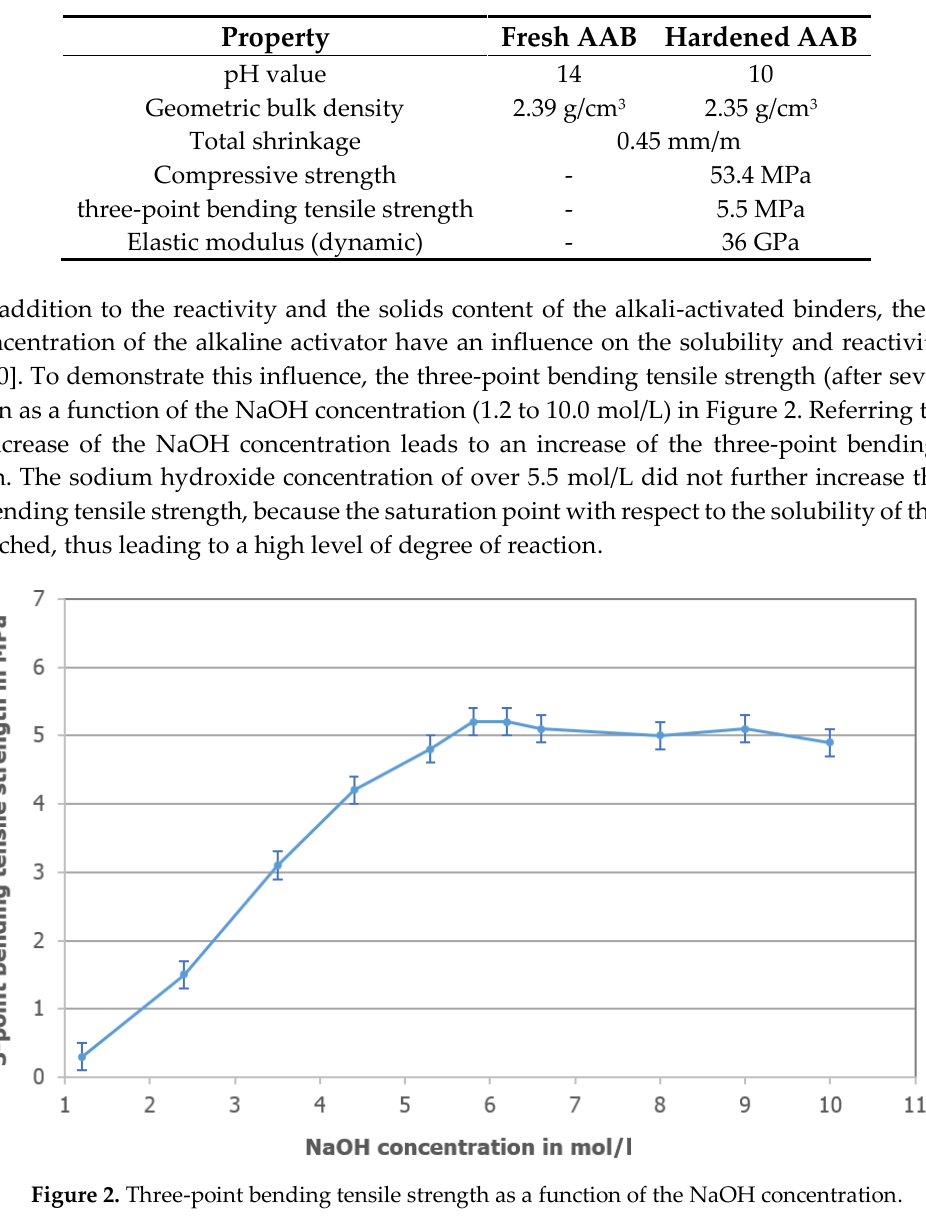
Table 4. Basic properties of fresh and hardened AABs (NaOH: 5.5 mol/L).